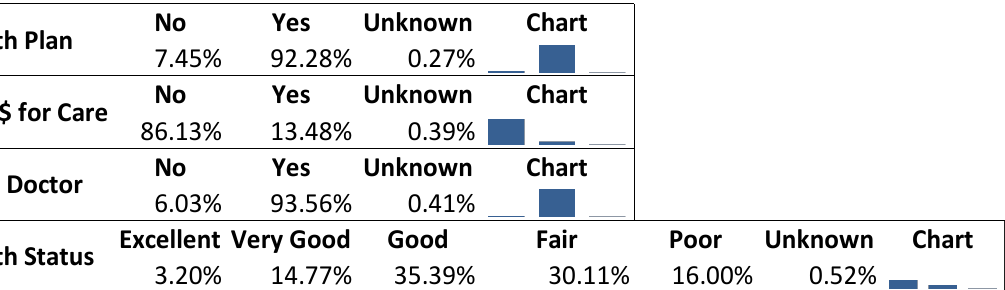
Figure 4. Marginal distributions for income, education, and employment.